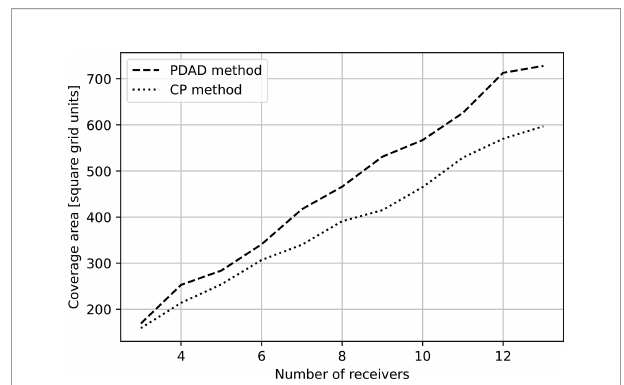
FIGURE 5 | Area covered by deployment setup based on CP method, i.e., positioning the receivers at the vertices of equilateral triangles vs. deployment based on the proposed PDAD method, i.e., optimization of receivers locations based on the surrounding environmental conditions.